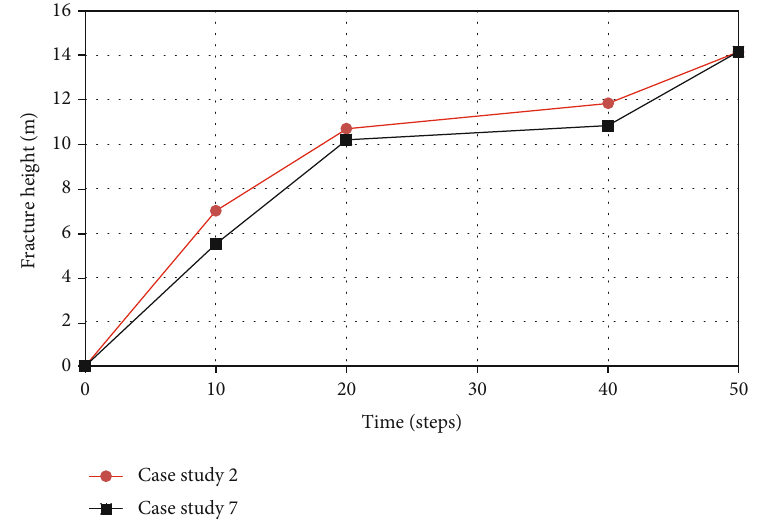
Figure 22: Comparison of fracture height between case 2 and case 7.